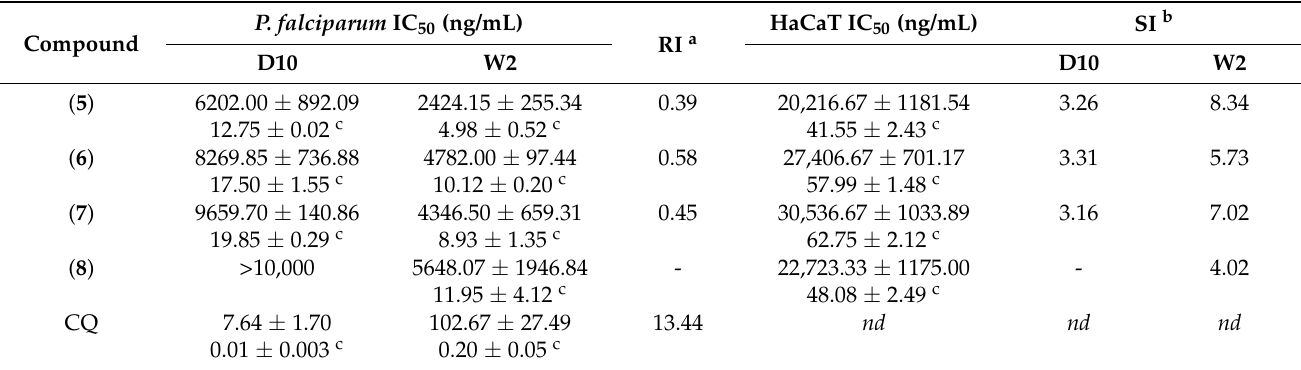
Table 3. In vitro antimalarial activity of compounds ( 5 – 8 ) against the D10 (CQ-sensitive) and W2 (CQ-resistant) strains of P. falciparum , cytotoxicity on HaCaT cells and relevant RI and SI.